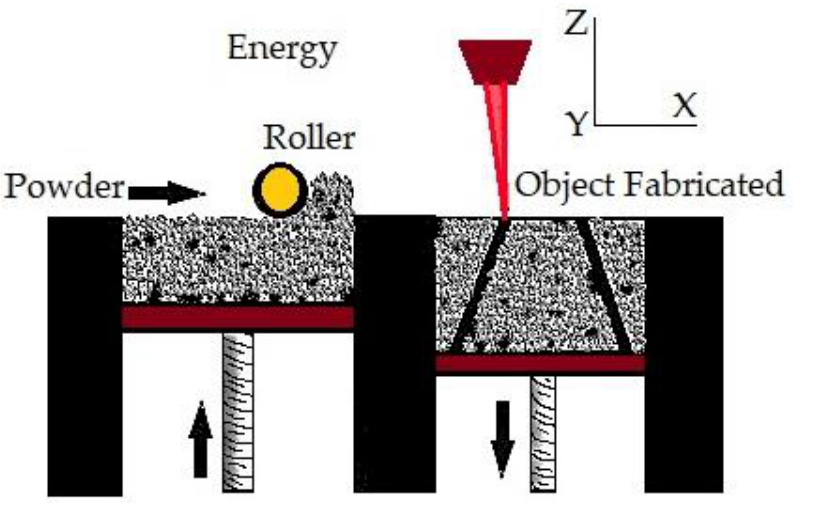
Figure 3. Powder bed fusion.